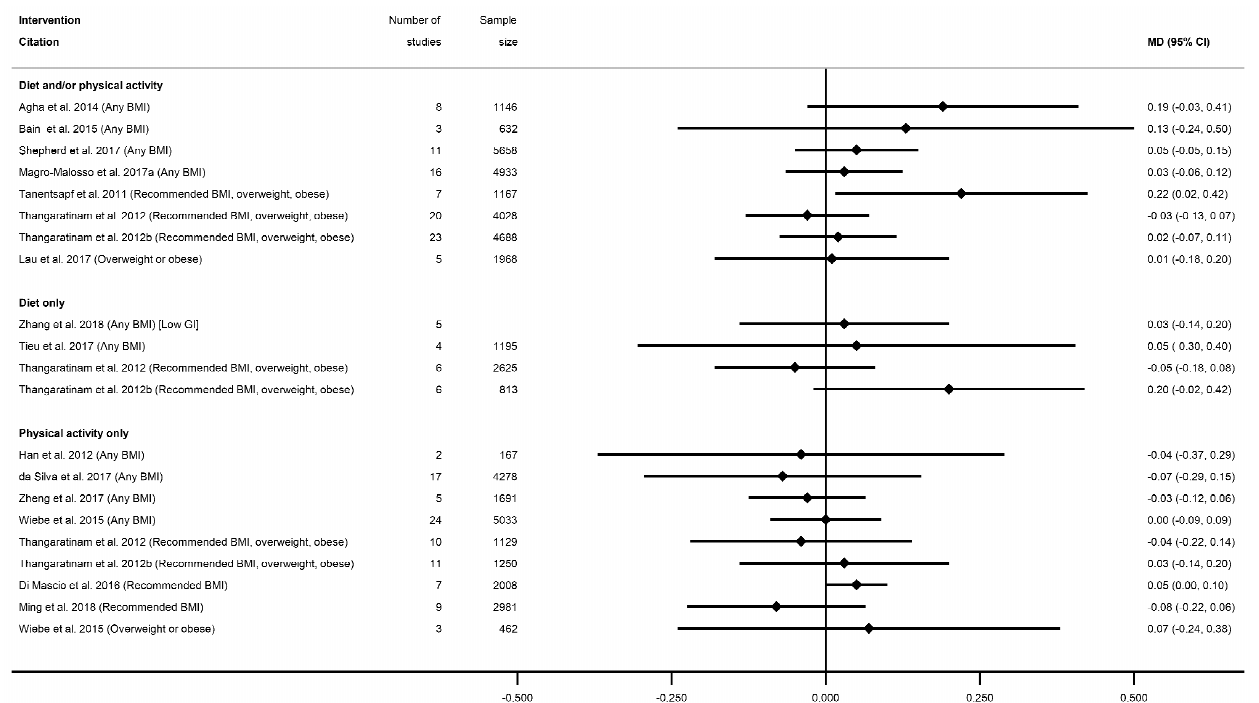
Figure 13. Forest plot of meta-analysis results for gestational age at